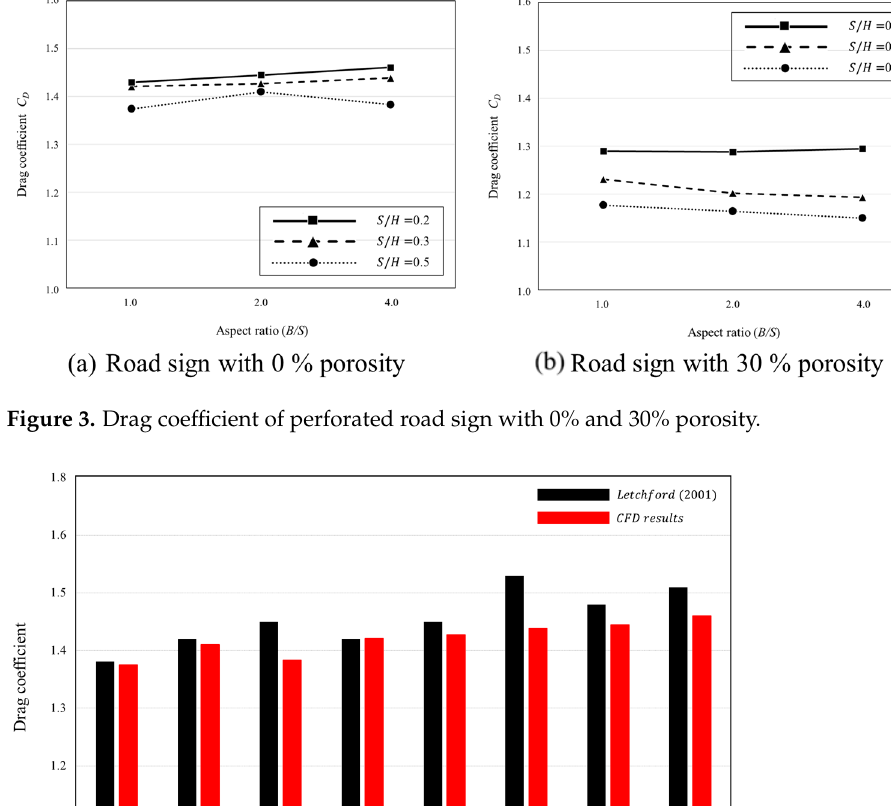
Figure 3. Drag coefficient of perforated road sign with 0% and 30% porosity.